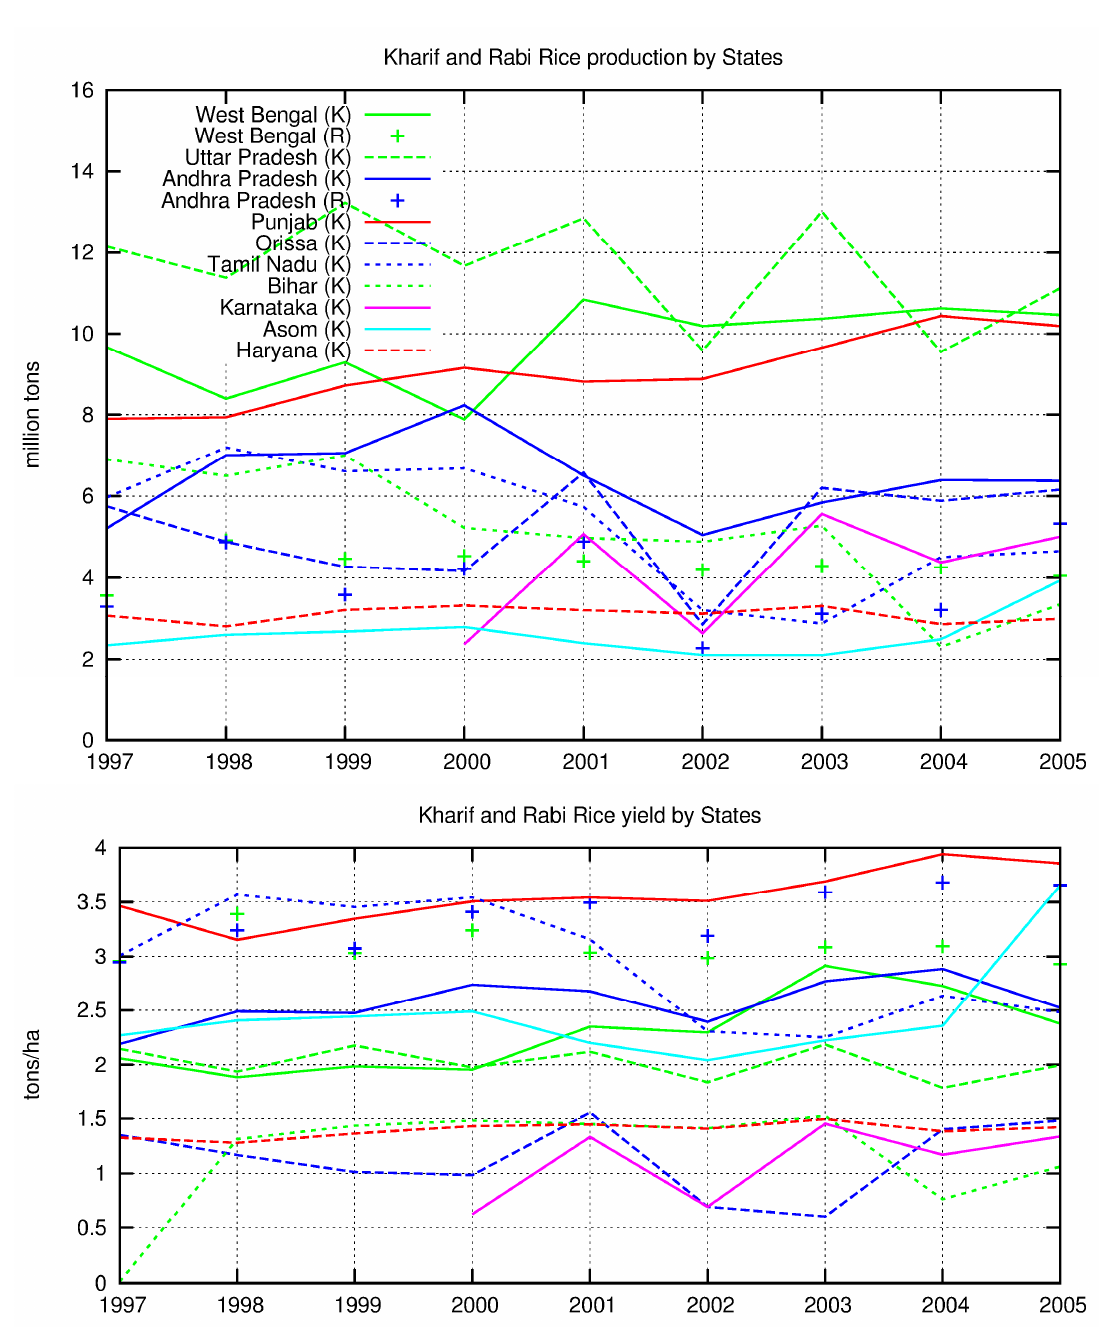
Figure 8. Time series of production and yield anomalies for the top 10 rice producing states in India ( top and bottom panel, respectively). Green indicates the states in the Ganges basin, blue indicates the states in the south eastern coast, red indicates the ones in the northwest, mainly in the Indus basin, correspondingly to the boxes depicted in Figures 2 and 5. Lines indicate Kharif Rice. Crosses indicate Rabi Rice.